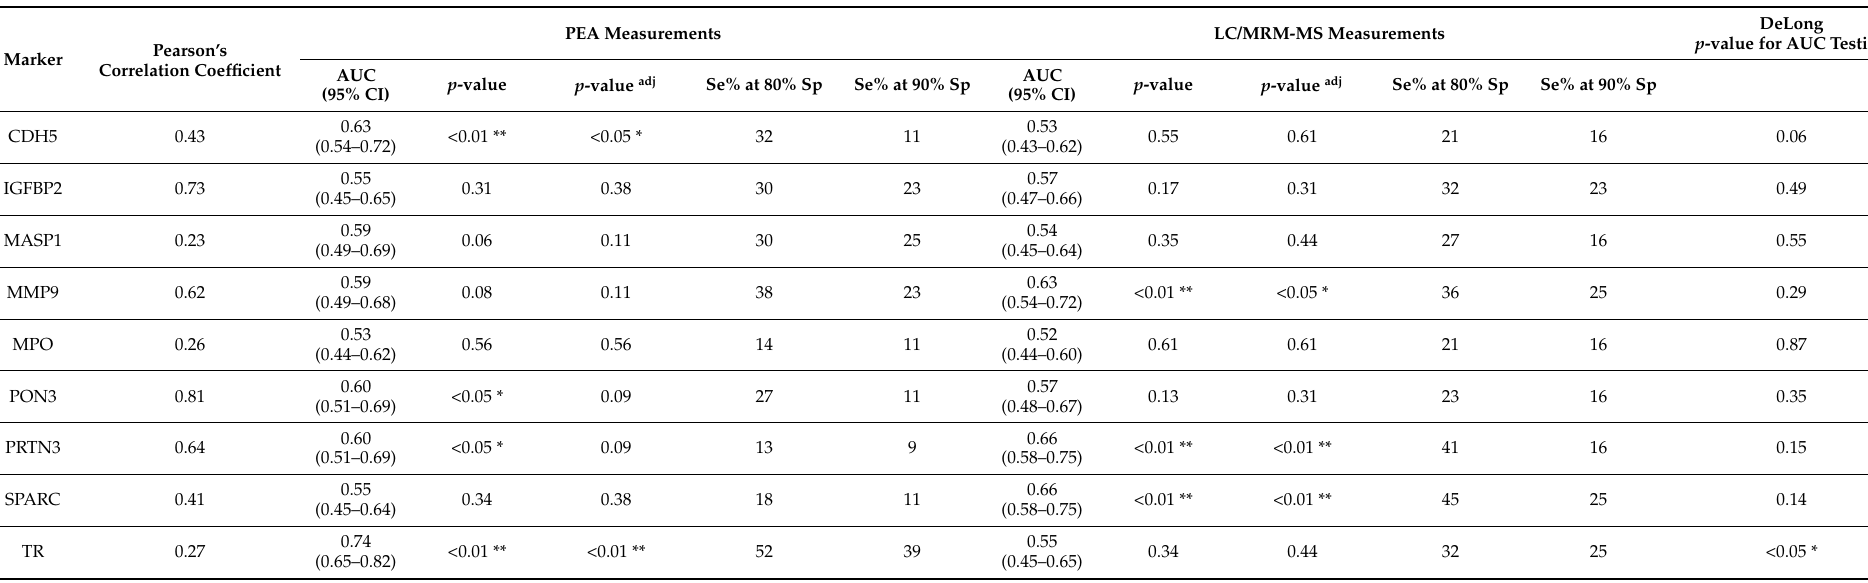
Table 2. Diagnostic performance of nine biomarkers overlapping between PEA and LC/MRM-MS measurements for detecting CRC cases from participants in screening colonoscopy PEA Measurements Marker Pearson’s Correlation Coefficient